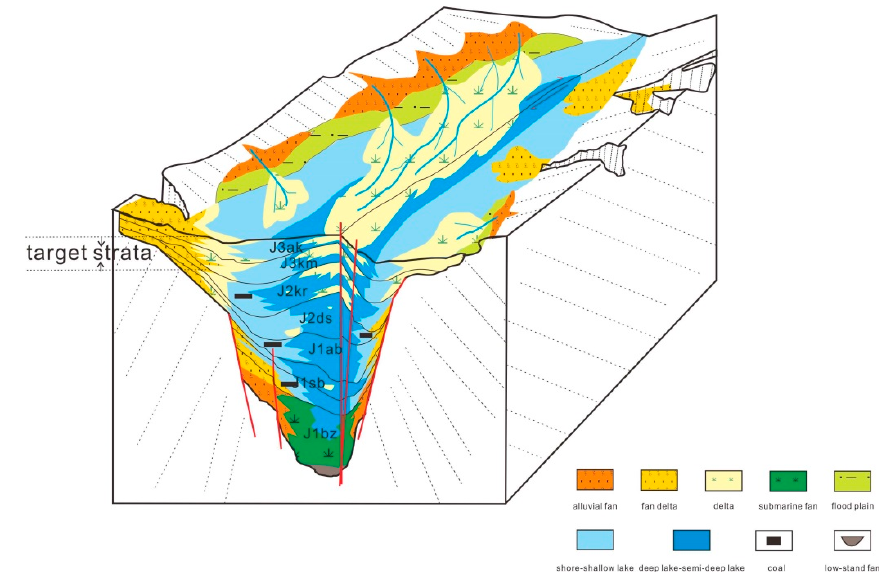
Figure 3. Map of sedimentary mode in the Jurassic, Aryskum Graben.